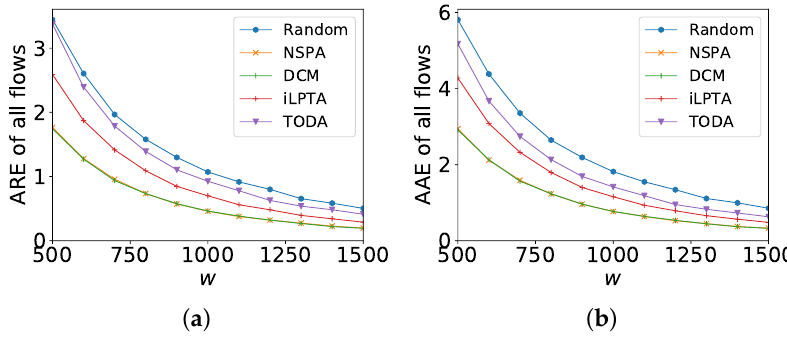
Figure 7. Measurement accuracies of all flows with different w . ( a ) ARE; ( b )